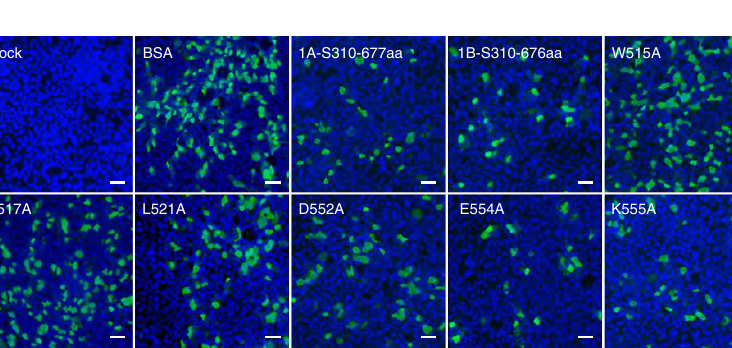
Figure 6 | Inhibition of HKU1 virus entry by mutant 1A-S310-677aa proteins. ( a ) The purified mutant proteins were assayed for their affinity to monoclonal antibodies mHKUS-2, mHKUS-4, and mHKUS-6 by ELISA. Differentiated HTBE cells were incubated with 20 m M of 1A-S310-677aa, 1B-S310-676aaor mutant CTD proteins at 37 (cid:2) C for 1h. HKU1 viruses were diluted into the same amount of proteins and added onto the HTBE cells for 4h. The released viruses from apical wash at 24h post inoculation were analysed using real-time PCR ( b ), and cells were fixed and stained with polyclonal rabbit anti HKU1 S antibodies 1814 at a dilution of 1:100 at 48h post inoculation ( c ). Scale bar, 50 m m. The amount of HKU1 viral RNA in the BSA control was set as 100%. The experiments were done in triplicate, and the s.d.‘s ( n ¼ 3) were shown as error bar. The experiments were performed twice and one representative is